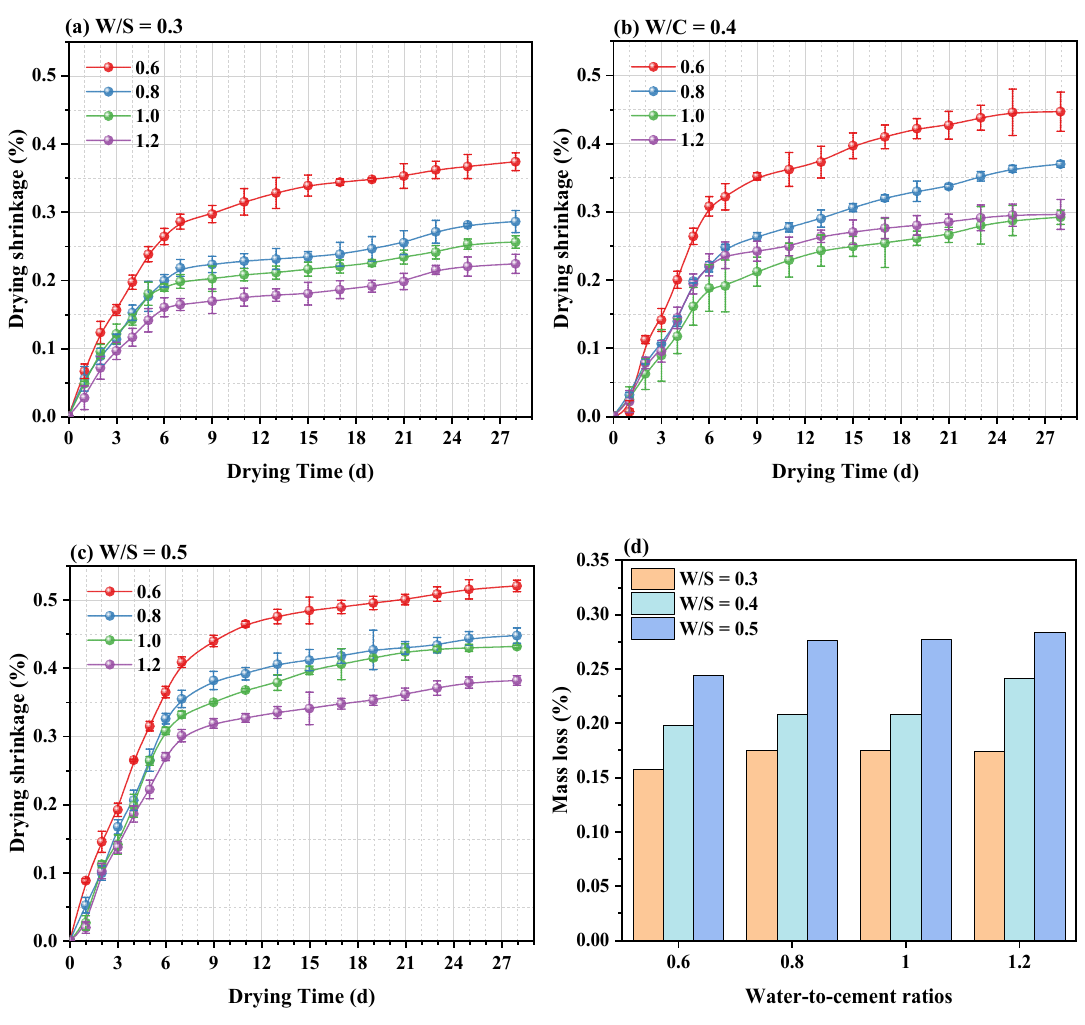
Figure 5. Drying shrinkage ( a – c ) and mass loss ( d ) of hardened CPB